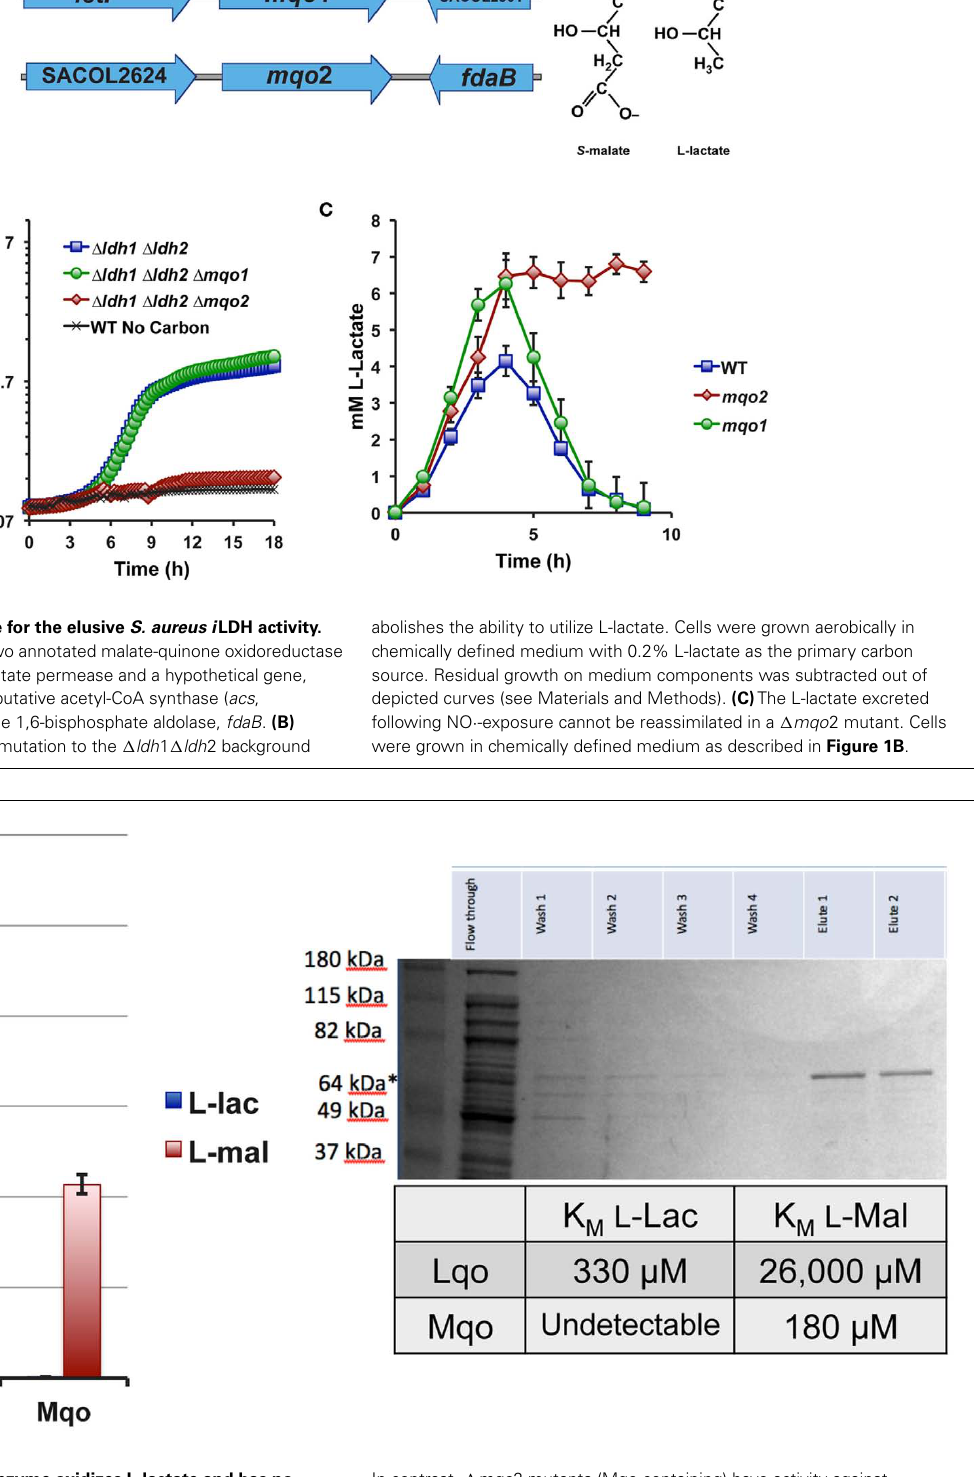
In contrast, Δ mqo 2 mutants (Mqo-containing) have activity against malate but not L-lactate. Right: Purified His6-tagged versions of Lqo and Mqo were used to determine affinities of each enzyme to its cognate